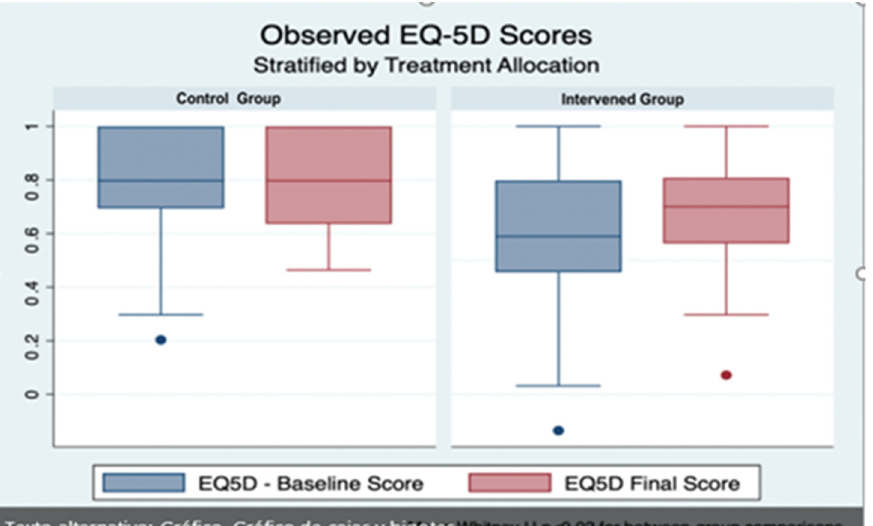
Figure 8. Boxplot showing the overall effects of the Quida platform in EQ-5D questionnaire between groups, before (blue) and after (red) the intervention. A statistically significant improvement from the baseline score was noted amongst participants allocated to the interventional arm ( p < 0.01 Wilcoxon sign-rank test). When these changes were compared between groups, statistical significance was reached (Mann–Whitney U-test p <